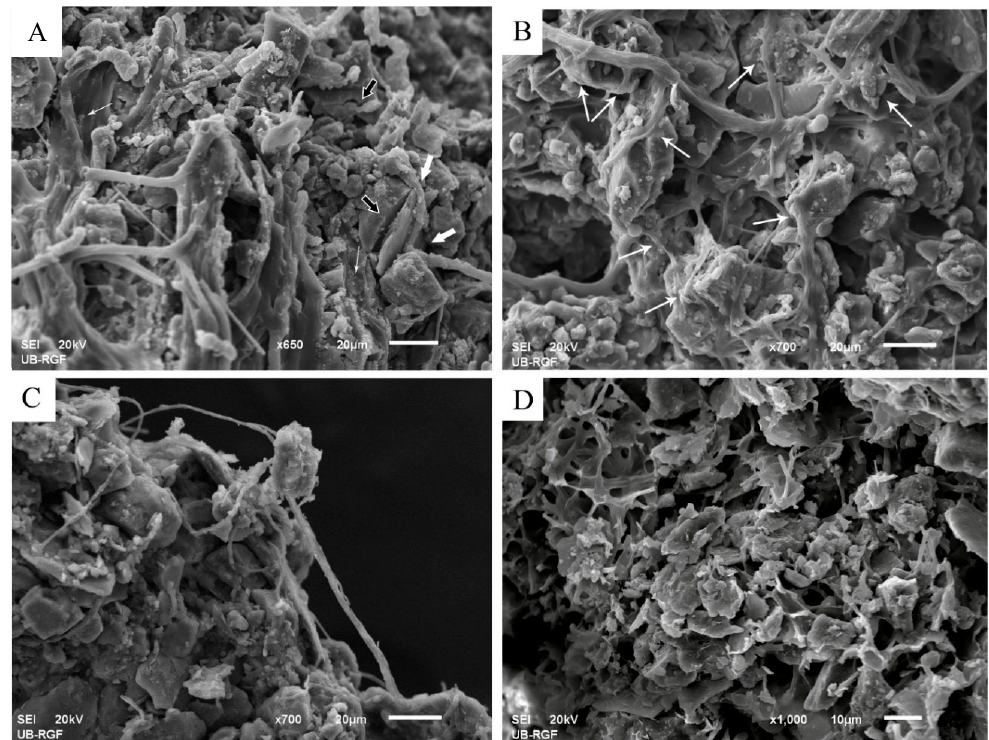
Figure 9. Representative SEM images showing stabilization of loess particles through organomineral structures. The weathering of the particles promoted by the EPS took place in and around the contact zone of the EPS and the particles ( A and B ). The weathering led to the breakage of some particles ( A , black arrows). The precipitation of minerals on the EPS surface ( A , thin white arrows). Organomineral structures that build the mineral bond between the EPS and the particles ( A , thick white arrows, and B , arrows). Although the particle has separated from the aggregate, it is still firmly attached to the tubular EPS, which is ensured by organomineral structures ( C ). The complex of mineralized EPS residues and weathered particles observed in the subcrust ( D ).